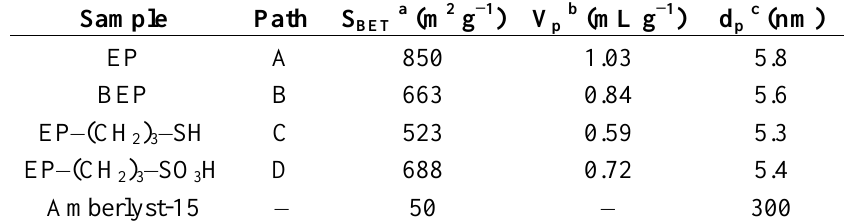
Table 1. Overview of the structural characteristics of the materials compared in this study.